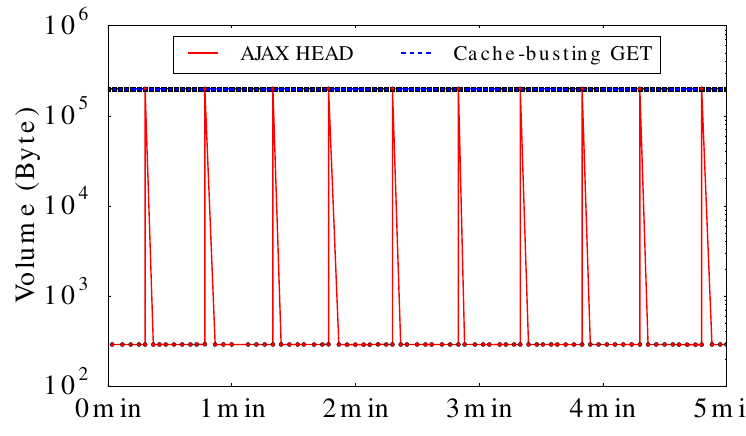
Figure 7. HTTP response size results for the two